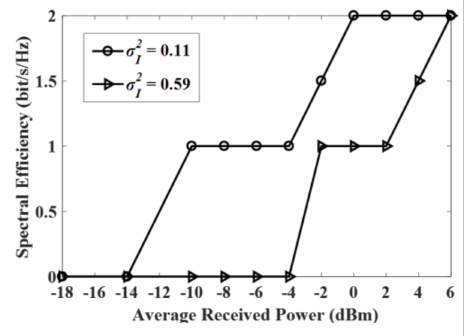
of 0.11 and ( b ) σ 2 of 0.59. I I